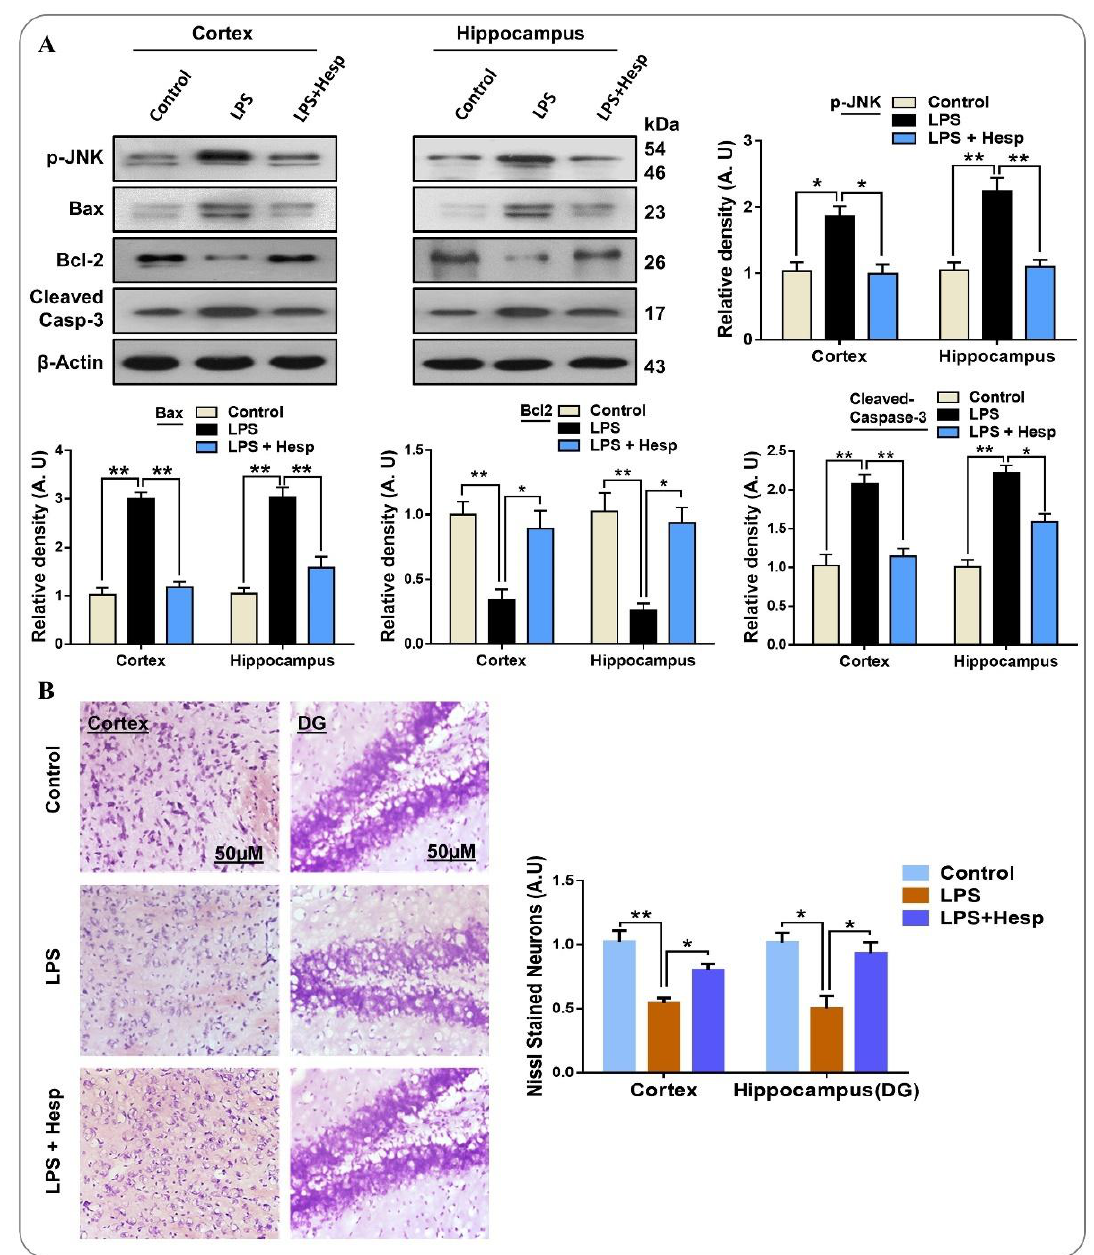
Figure 7. Hesperetin reversed the LPS-induced apoptotic cell death in the mouse brain and enhanced cell viability in vitro: ( A ) Western blot analysis of stress kinase p-JNK and pro-apoptotic protein Bax and cleaved-Caspase-3 and anti-apoptotic protein expression differential experiential groups and their histograms respectively; ( B ) photomicrograph of Nissl’s staining in the cortex and DG regions of the hippocampus in the mouse brain. The data are presented as the mean ± SEM of 7–10 mice per group and are representative of three independent experiments, * p ≤ 0.05, ** p ≤ 0.01.